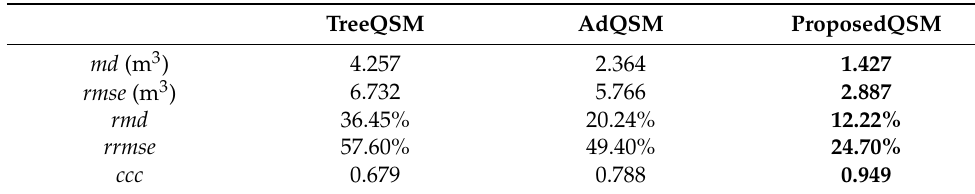
Table 3. Volume accuracy metrics of different method. The bold font means the lowest or highest value comparing with other